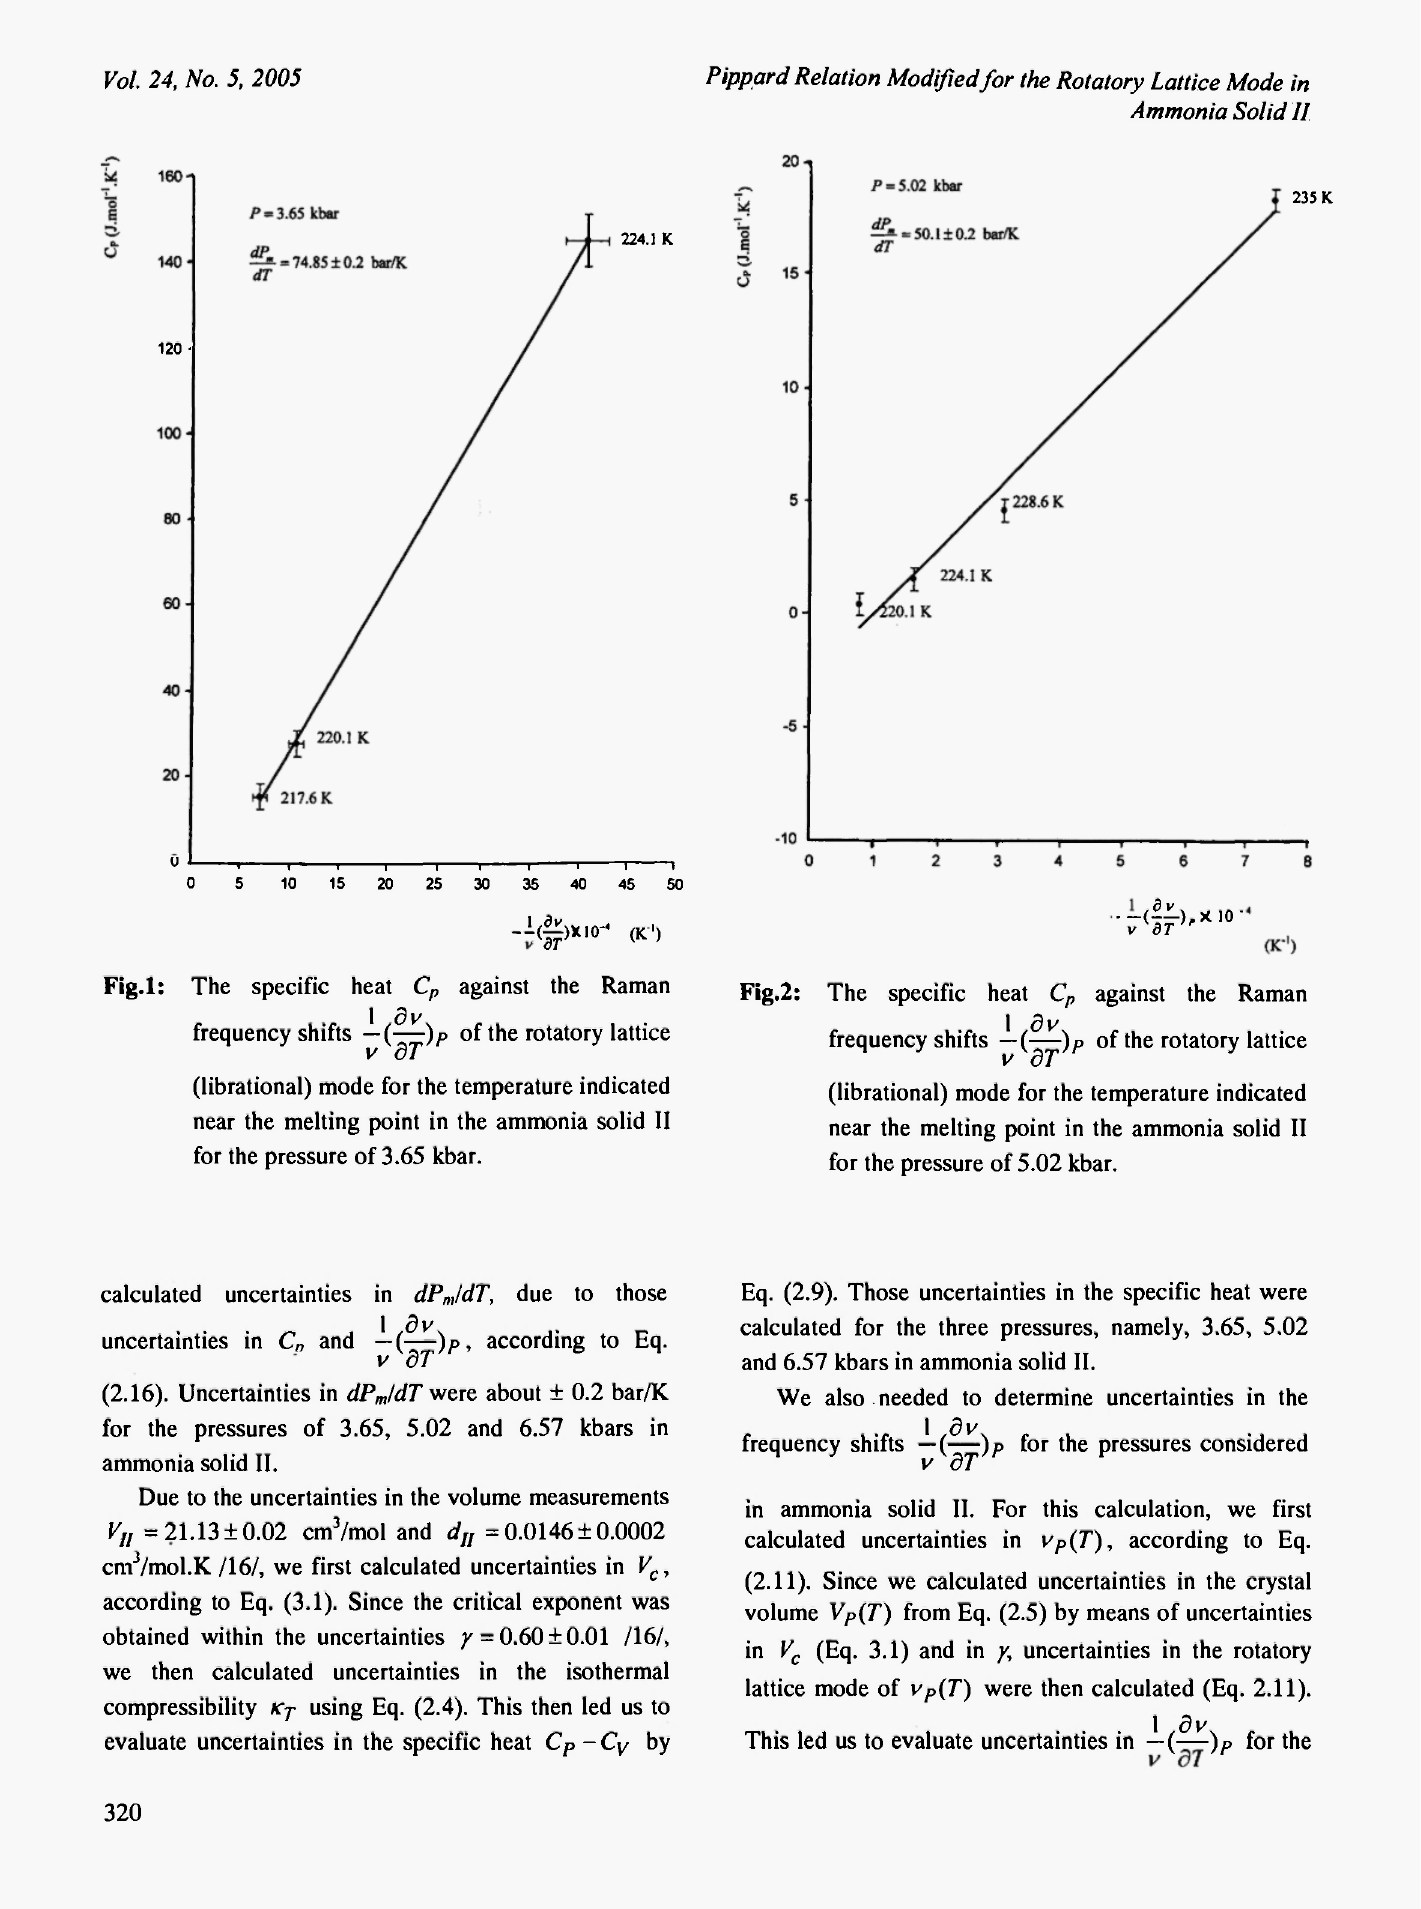
Fig.l: The specific heat C p against the Raman 1 dv frequency shifts — ( — ) P of the rotatory lattice ν dT (librational) mode for the temperature indicated near the melting point in the ammonia solid II for the pressure of 3.65 kbar.